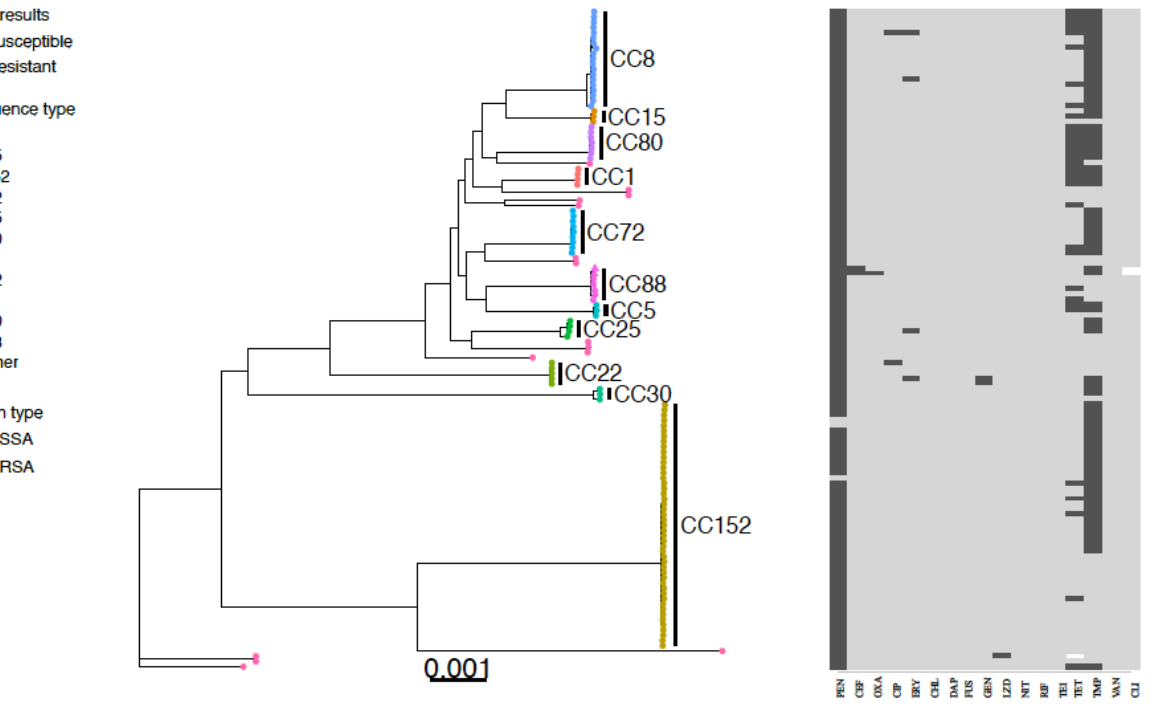
Figure 1. Core genome phylogenetic tree and antibiogram of MSSA and MRSA isolates colonizing abattoir workers in western Kenya. Predominant ST types are differentiated by colour, MRSA isolates are indicated by a triangle symbol and MSSA by circles. Phenotypic antimicrobial resistance is indicated by dark grey bars (resistant), white bars (intermediate), and light grey (susceptible). Antimicrobials: PEN — benzylpenicillin, CEF — cefoxitin, OXA — oxacillin, CIP — ciprofloxacin, ERY — erythromycin, CHL — chloramphenicol, DAP — daptomycin, FUS — fusidic acid, GEN — gentamicin, LZD- linezolid, NIT — nitrofurantoin, RIF — rifampicin, TEI — teicoplanin, TET — tetracycline, TMP — trimethoprim, VAN — vancomycin, CLI — clindamycin.